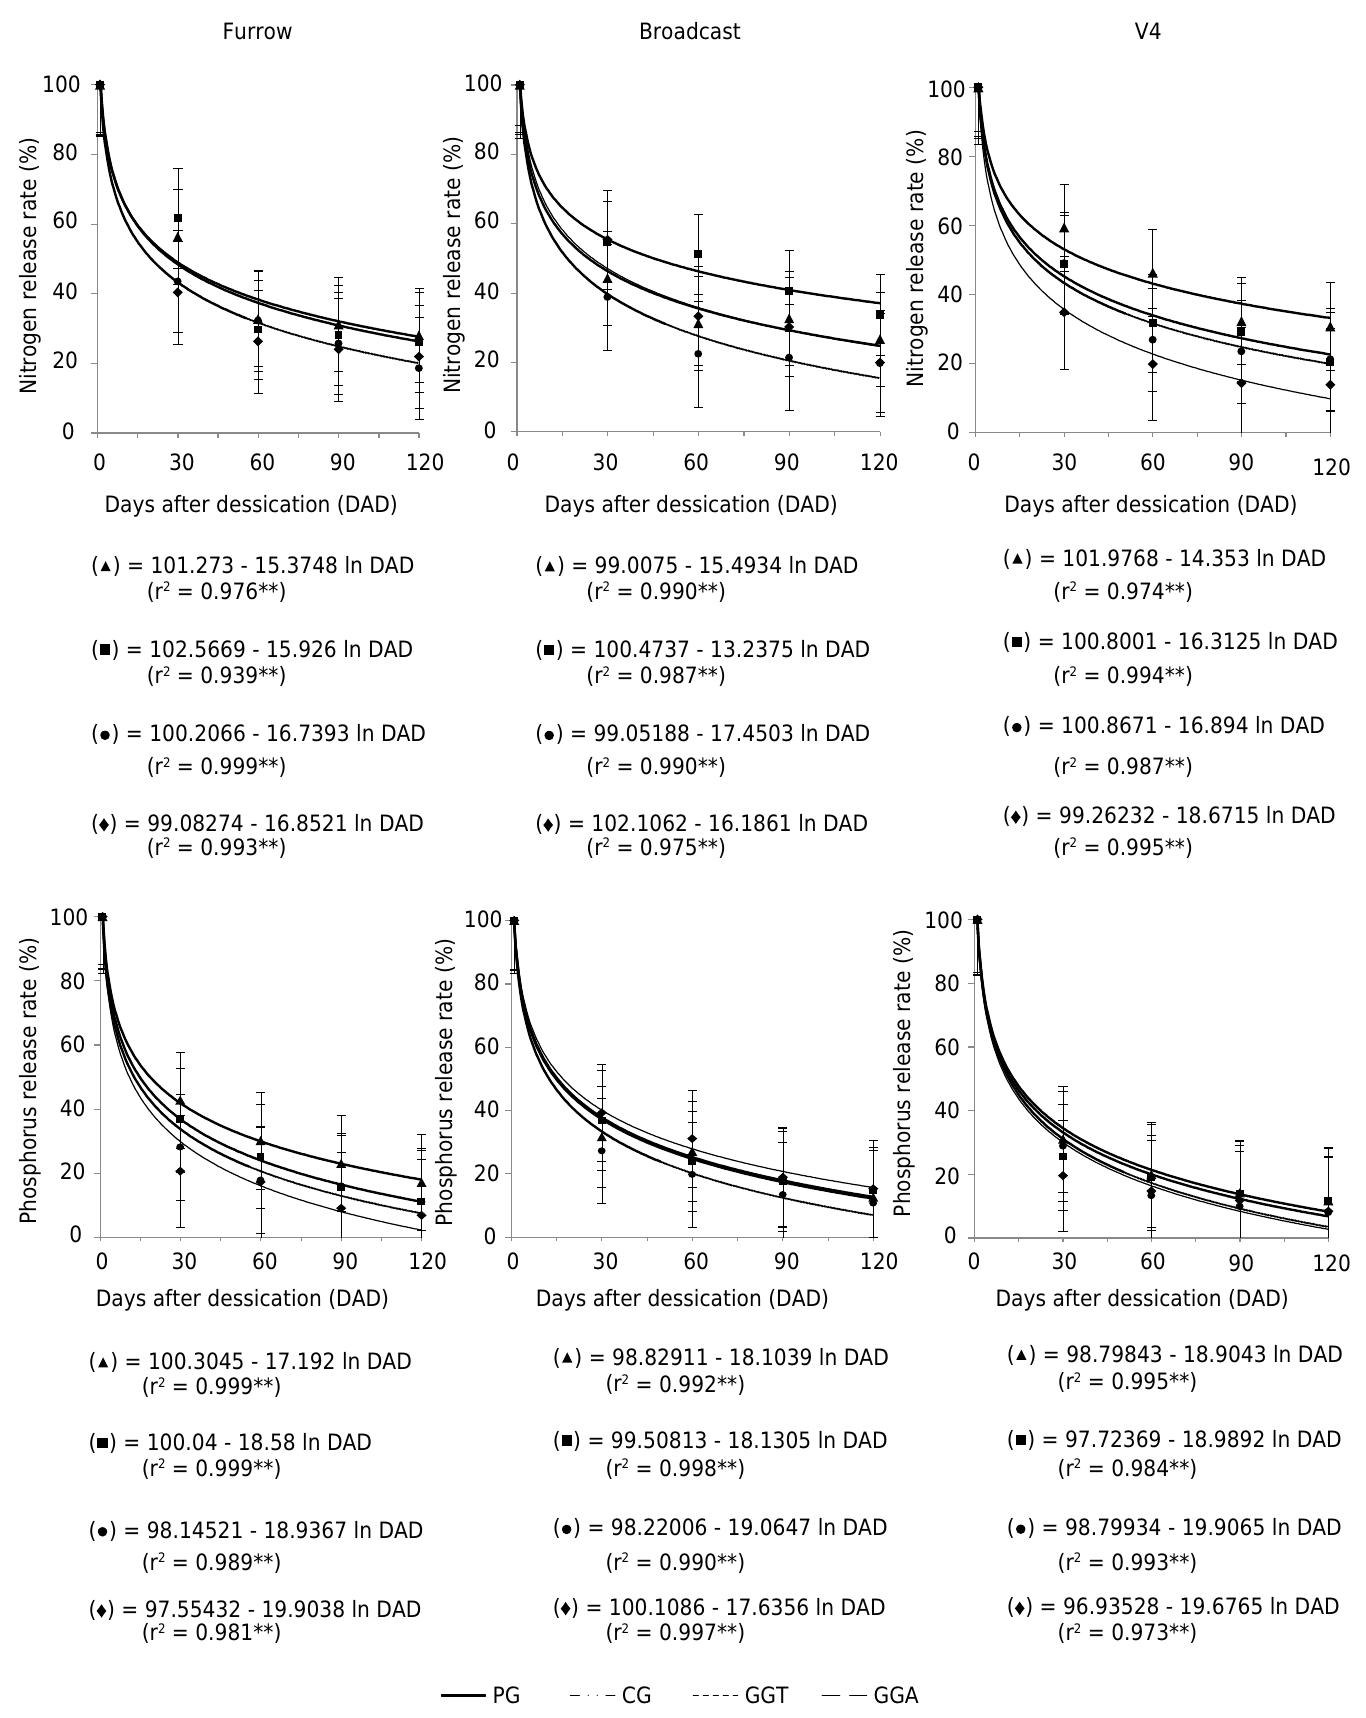
Figure 3. Nitrogen and phosphorus release rate from forage straw after desiccation, in three methods of sowing forage-autumn maize intercrops. PG, CG, GGT and GGA: Palisade grass, Congo grass, Guinea grass cv. Tanzânia and Guinea grass cv. Áries, respectively. **: significant at 1